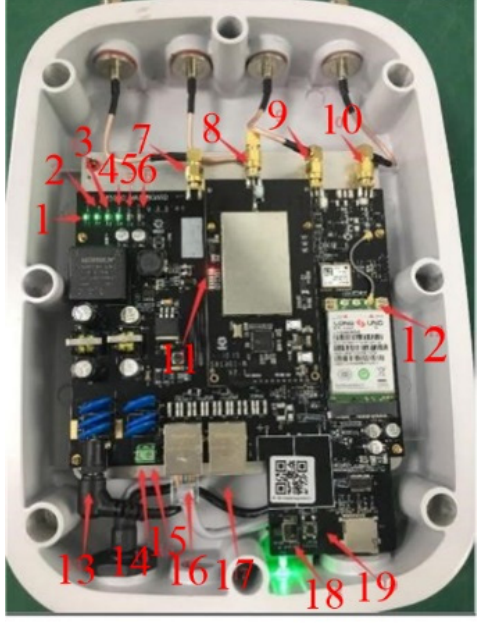
Figure 19. The LoRaWAN gateway hardware.